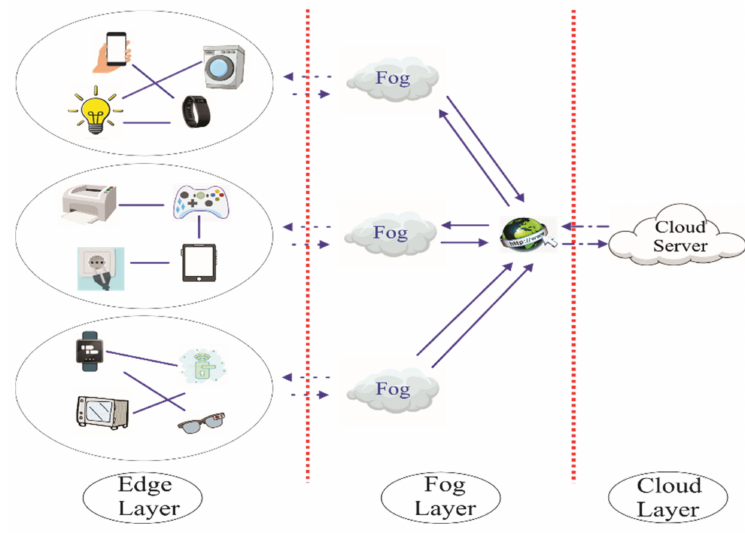
Figure 2. Specified system architecture.